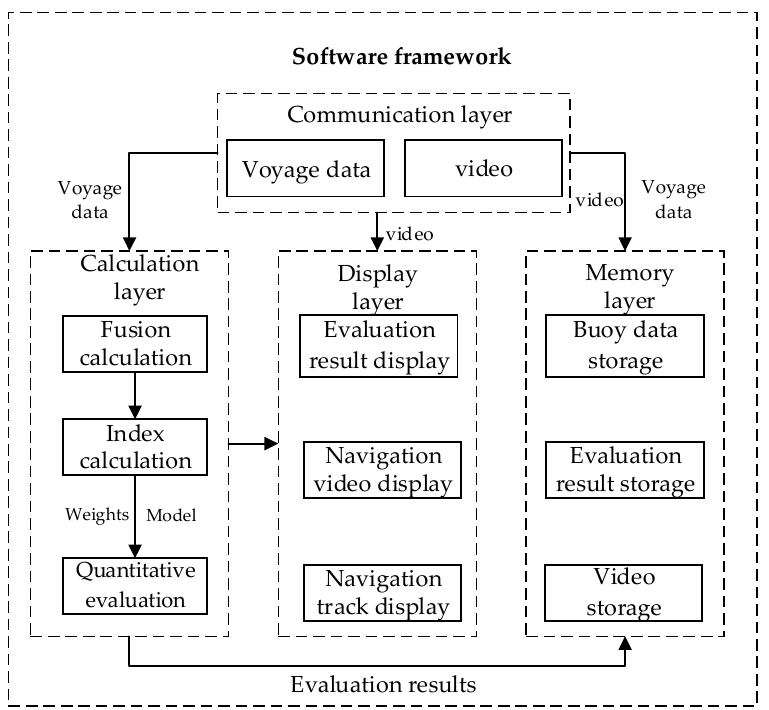
Figure 3. Software framework for quantitative evaluation of the obstacle avoidance performance.